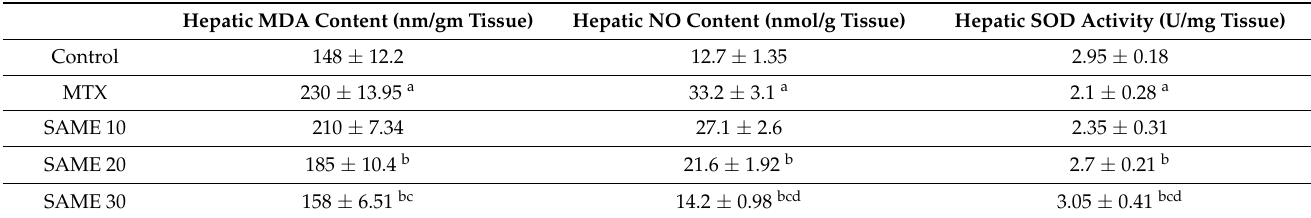
Table 4. Effects of the SAME Pre-treatment on hepatic MDA level, hepatic NO content, and hepatic SOD activity in MTX-induced hepatotoxicity in mice.